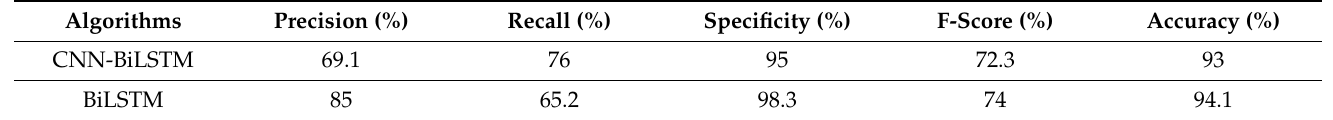
Table 3. Binary classification results of the proposed CNN-BiLSTM and BiLSTM models.